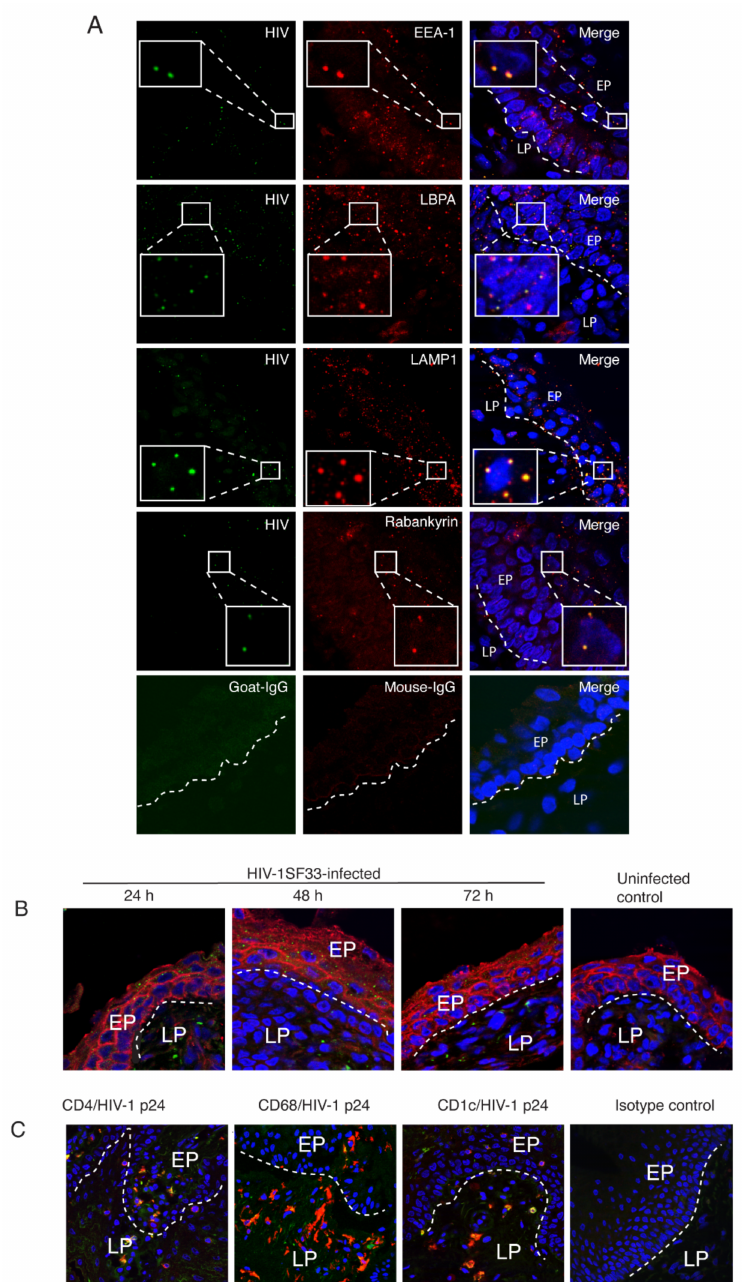
Figure 9. Penetration of HIV-1 into endosomal compartments of tonsil epithelium. ( A ) HIV-1 SF33 (100 ng/mL) was added to the mucosal surface of polarized-oriented tonsil explants, and after 4 h, one set of tissues was fixed, sectioned, and costained for HIV-1 p24 (green) and endosome markers EEA1, LAMP1, LBPA, and rabankyrin (red). ( B ) Polarized-oriented tonsil explants were infected with HIV-1 SF33 from the mucosal surface. Uninfected tissues served as a control. After 24, 48, and 72 h, tissue sections were coimmunostained for HIV-1 p24 (green) and occludin (red). ( C ) HIV-1 SF33 - infected tonsil tissue explants were maintained for 5 days, and sections were costained for HIV-1 p24 (green) and for markers of CD4 T lymphocytes, macrophages, and DC (red). Tissue sections were analyzed by confocal microscopy. Cell nuclei were counterstained in blue. EP, epithelium; LP, lamina propria. In merged panels, yellow indicates colocalization of HIV-1 p24 with endosome markers or markers of T lymphocytes, macrophages, and DC. Magnification: × 400. Results were reproduced in two independent